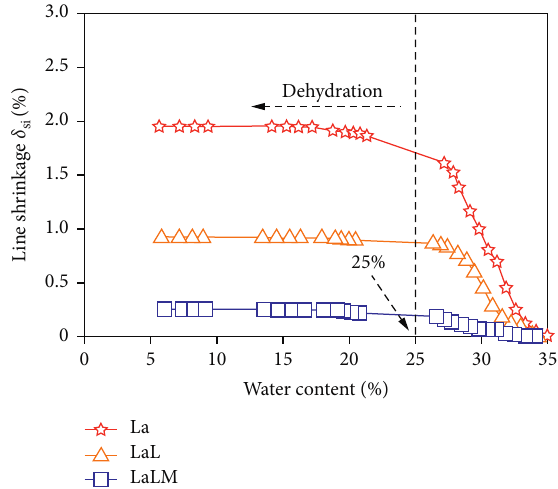
Figure 8: Shrinkage curves of treated and untreated laterite.